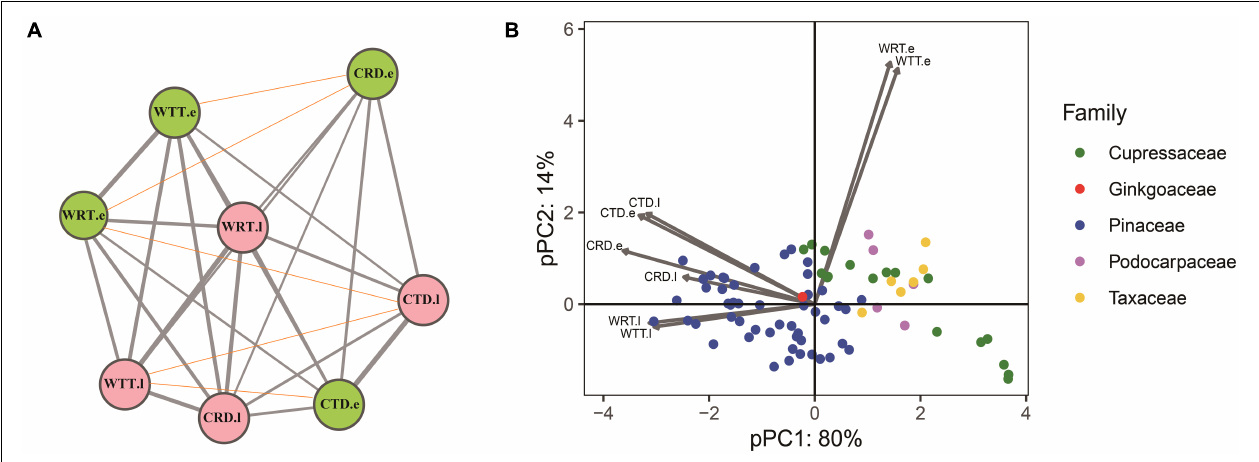
FIGURE 3 | Results of a correlation analysis and principle component analysis for tracheid traits in a phylogenetic context. (A) Correlations among PICs of the eight tracheid traits. Pink and green colors stand for earlywood and latewood, respectively, the width of gray lines stands for positive correlation coefficients between two traits, while red thin lines stand for non-significant correlations. (B) pPCA of eight tracheid traits for conifers species from 5 families, showing that Pinaceae species and Cupressaceae species take up a different position along the first PC axis. Acronyms of xylem traits and environmental variables are same in Table 1 .